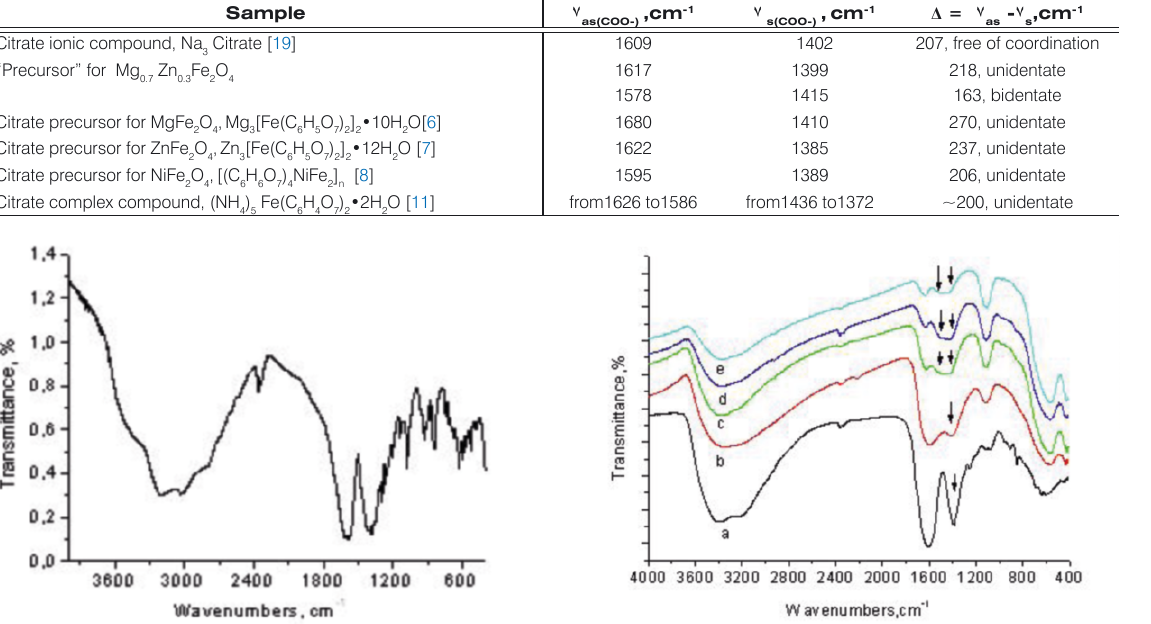
Figure 1. FTIR-spectrum of sample “Precursor”. Figure 2. FTIR-spectra of sample “Precursor” heat treated at: a) 100 ° C, b) 250 ° C, c) 350 ° C, d) 450 ° C and e) 600 ° C.